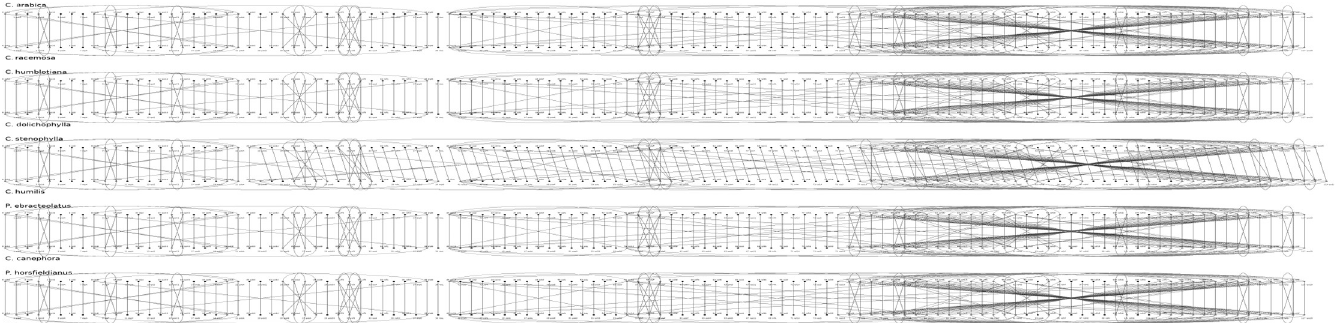
Fig 6. Cp genome gene contents for some pairwise comparisons based on GeSeq annotations. Each of the five images compares the two genomes of sister species in phylogeny. Each genome is represented as a dotted line, each dot being a gene (the dot is labeled by its name). A red curve indicates paralogy between genes inside a given genome, while a blue line is for gene orthology between two distinct genomes.